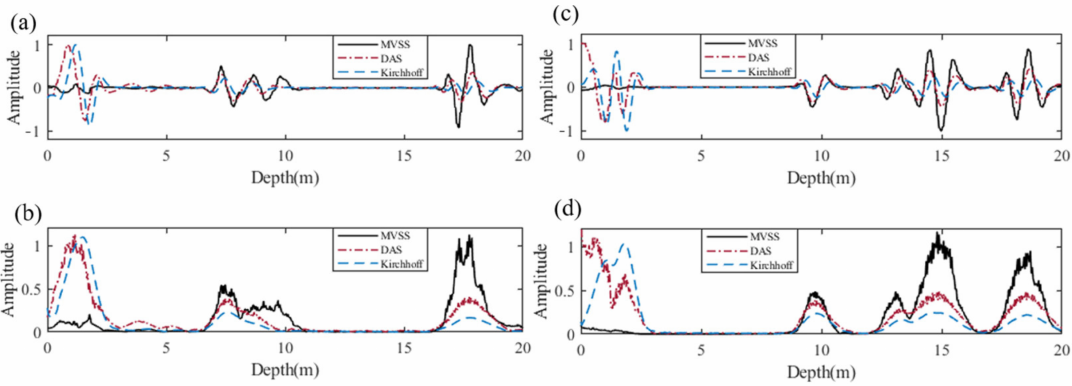
Figure 20. Imaging amplitude curves at x = 15 m and the Hilbert transform of each. ( a , b ) model B-2; ( c , d ) model